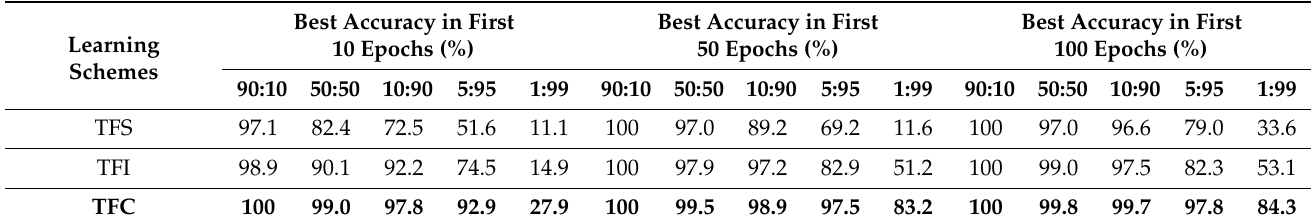
Table 3. Testing accuracy in the target task under three learning schemes and various splitting ratios of target-domain samples (each number is an average of five runs of